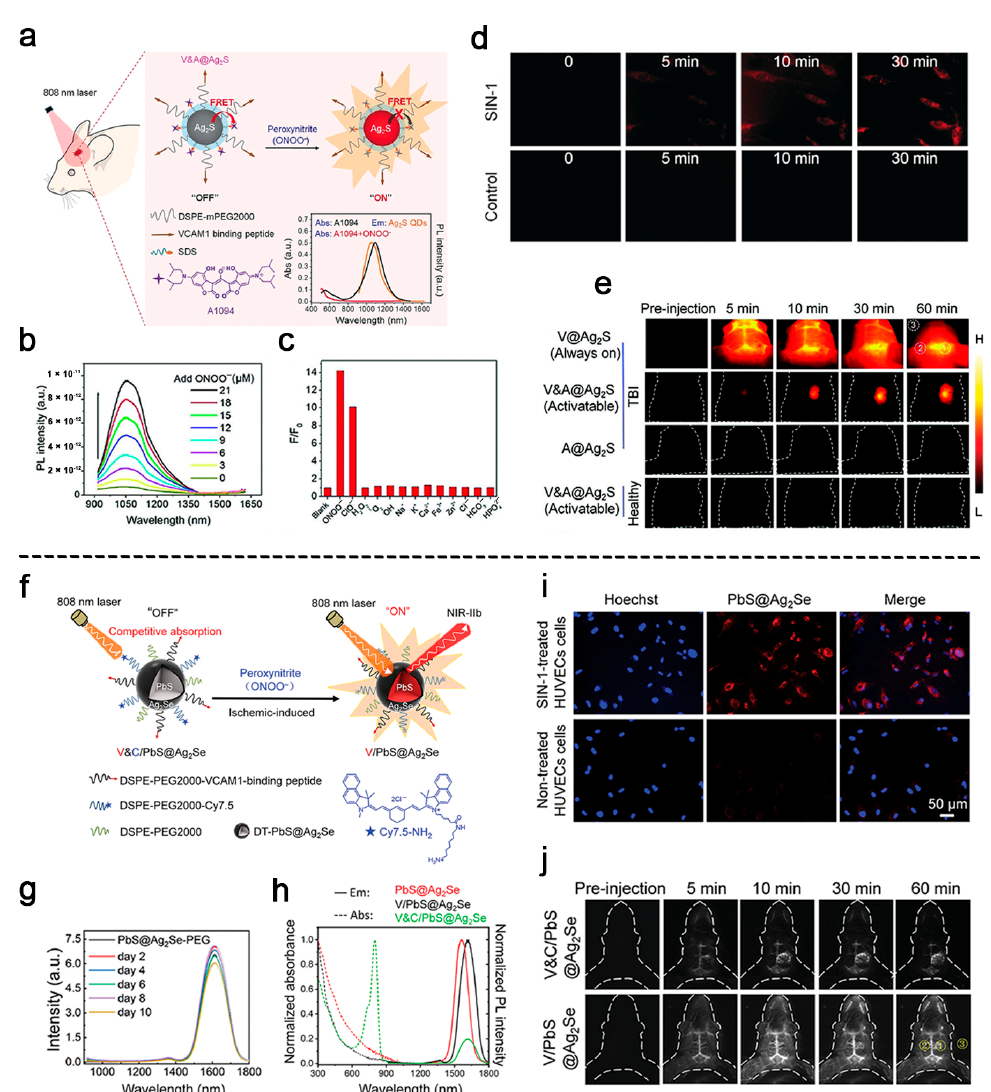
Figure 6. ( a ) Schematic diagram of the preparation process of the NIR-II nanoprobe V&A@Ag 2 S and the mechanism